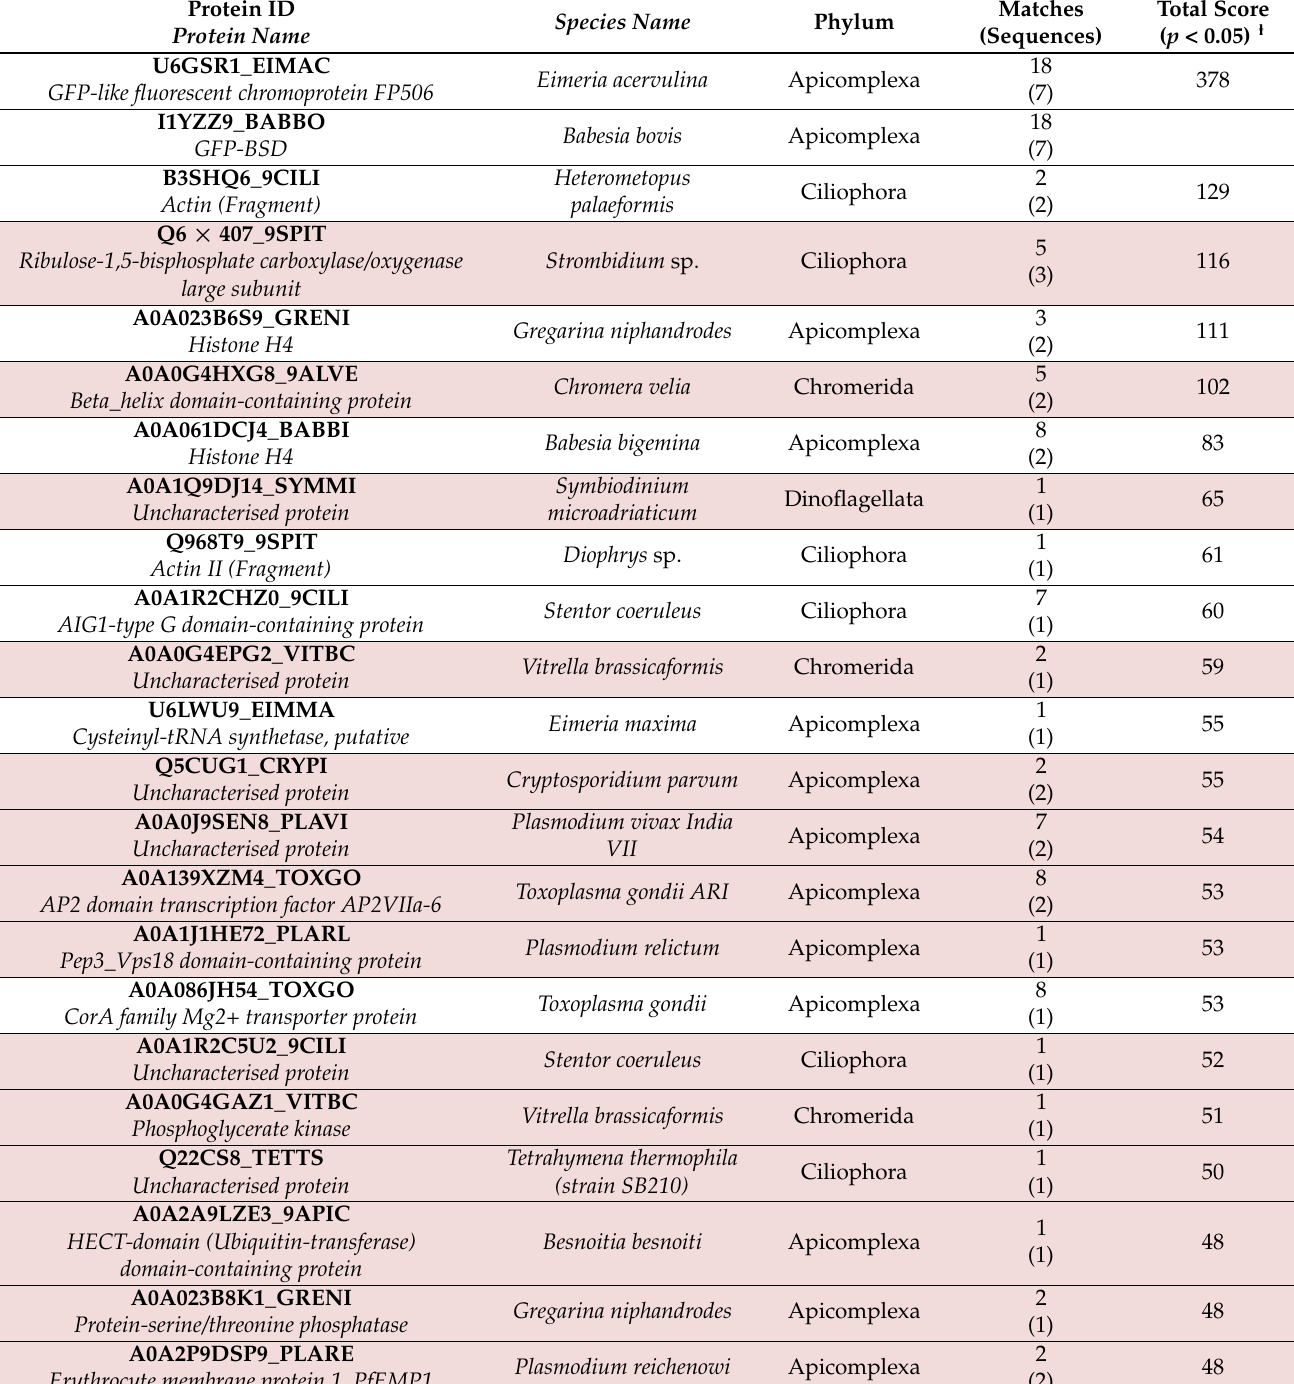
Table 1. Deiminated proteins in Piridium sociabile , as identified by F95-enrichment in conjunction with LC-MS/MS analysis. Deiminated proteins were isolated by immunoprecipitation using the pandeimination F95 antibody. The resulting F95-enriched eluate was then analysed by LC-MS/MS and peak list files submitted to Mascot, using a common Alveolata database. Peptide sequence hits are listed, showing species-specific hits, number of sequences for protein hits and total score. Species hit names and phylum are indicated; a full list of protein sequence hits and peptides is further provided in Supplementary Table S1. Proteins highlighted in pink were deimination candidate hits only identified in P. sociabile, not in M. kathae .